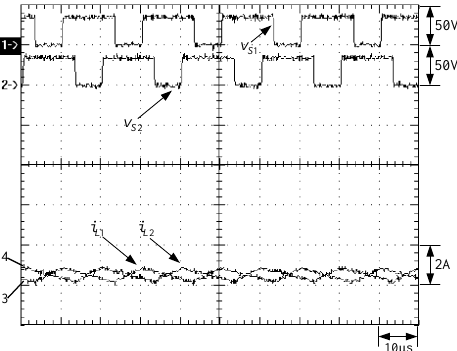
Appl. Sci. 2019 , 9 , x FOR PEER REVIEW Figure 22. Waveforms pertaining to S b at the minimum load: (1) v gb ; (2) v Sb ; and (3) i Sb .